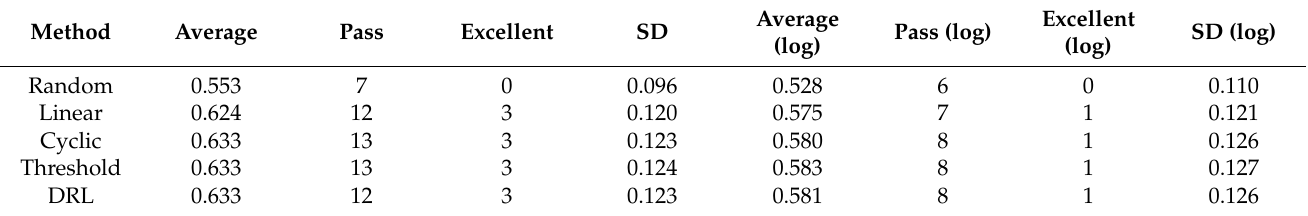
Table 6. The results of BKT that do not consider the knowledge point association.